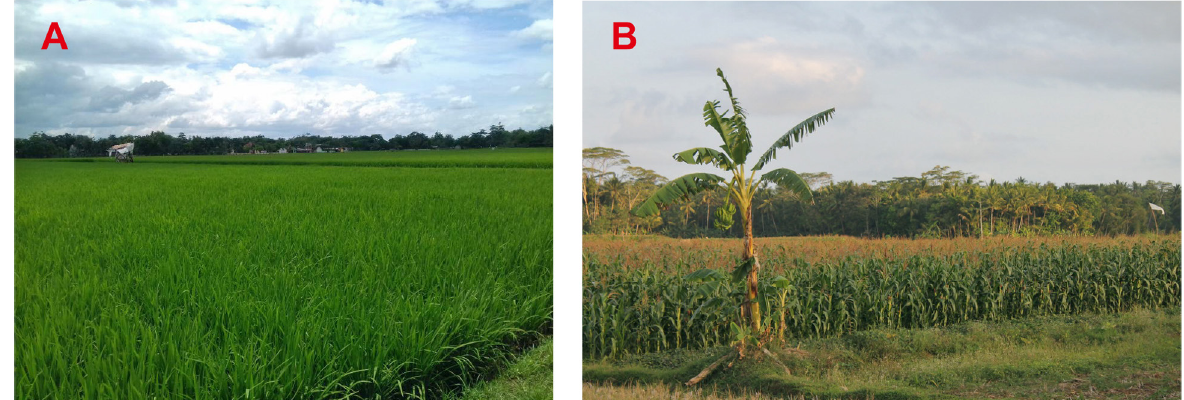
Fig. 6. Comparison of vegetation types in agricultural land during (A) wet season and (B) dry